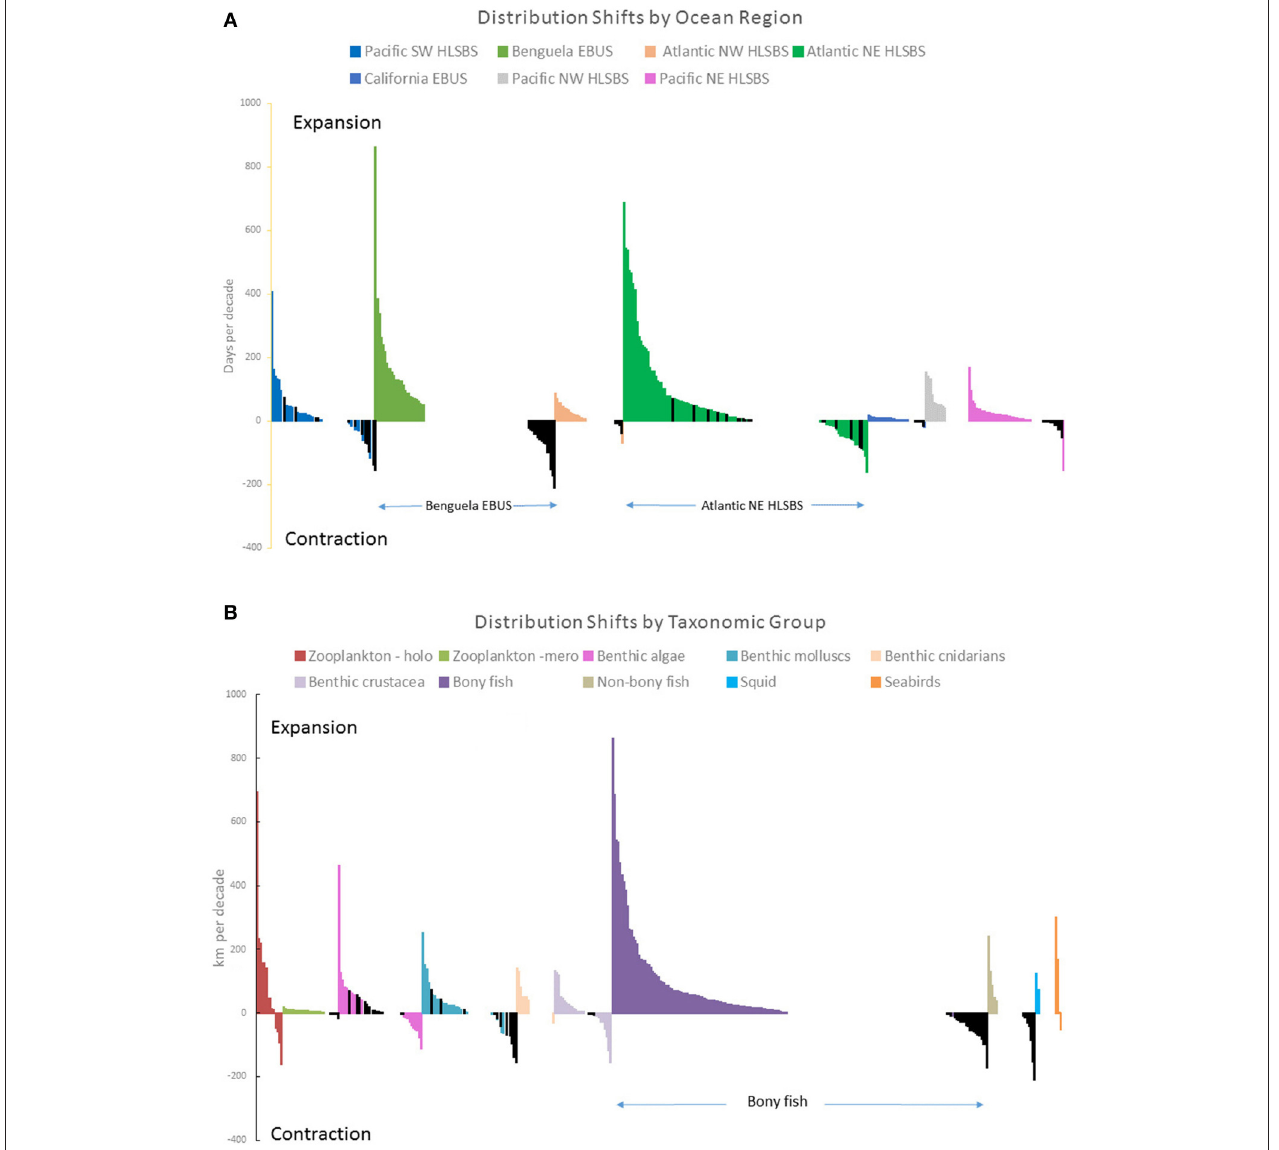
FIGURE 2 | Observed shifts in species distributions (km per decade) by (A) ocean regions and (B) taxonomic groups. Data from Poloczanska et al. (2013) updated with recent literature (2011–2015). Colored bars are consistent with expectations under climate change, black bars are equivocal, and zero values are no change. A description of ocean regions are given Fig 30-1 in Hoegh-Guldberg et al. (2014). Total number of observations =